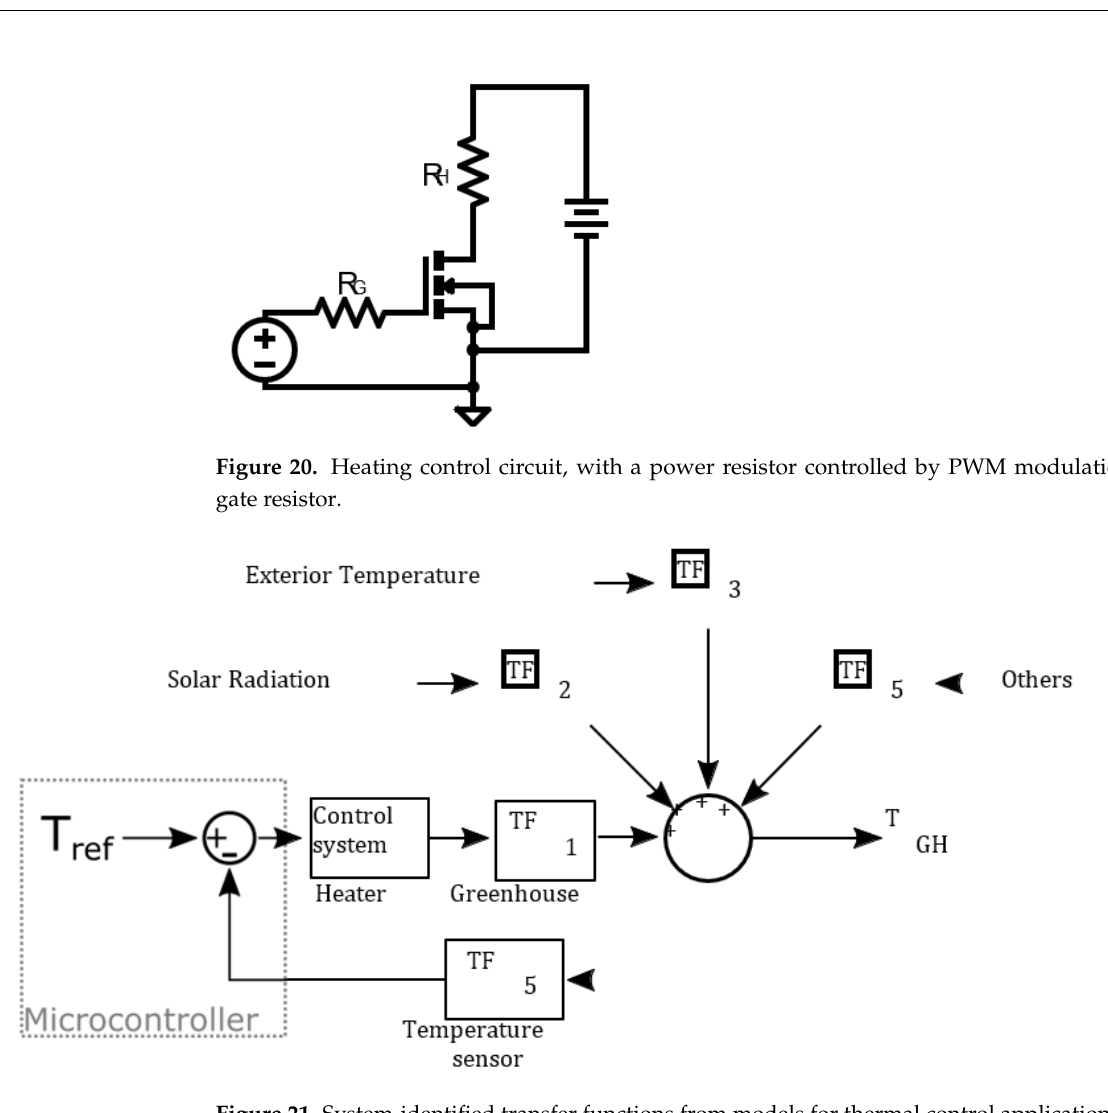
Figure 21. System-identified transfer functions from models for thermal control applications. (Based on [8]).